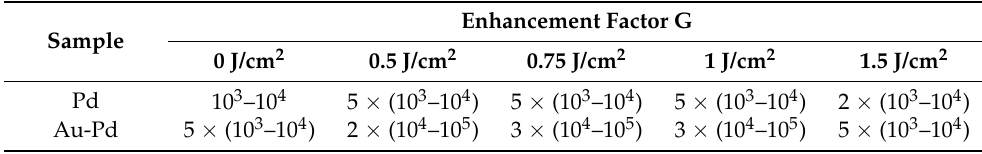
Table 1. Experimental values of enhancement factor for Pd and Au-Pd with different laser